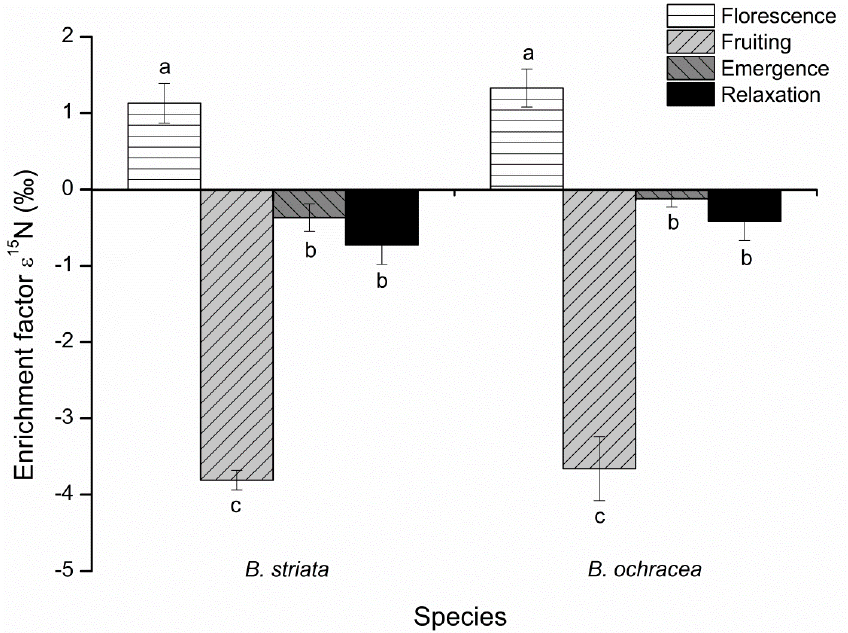
Figure 8. Enrichment factor ( ε ) for 15 N of Bletilla striata and B . ochracea collected at different phenological stages. Mean ε values of the autotrophic reference species are equal to zero. Different lowercase letters for each species indicate statistically significant differences among phenological stages ( p < 0.05).